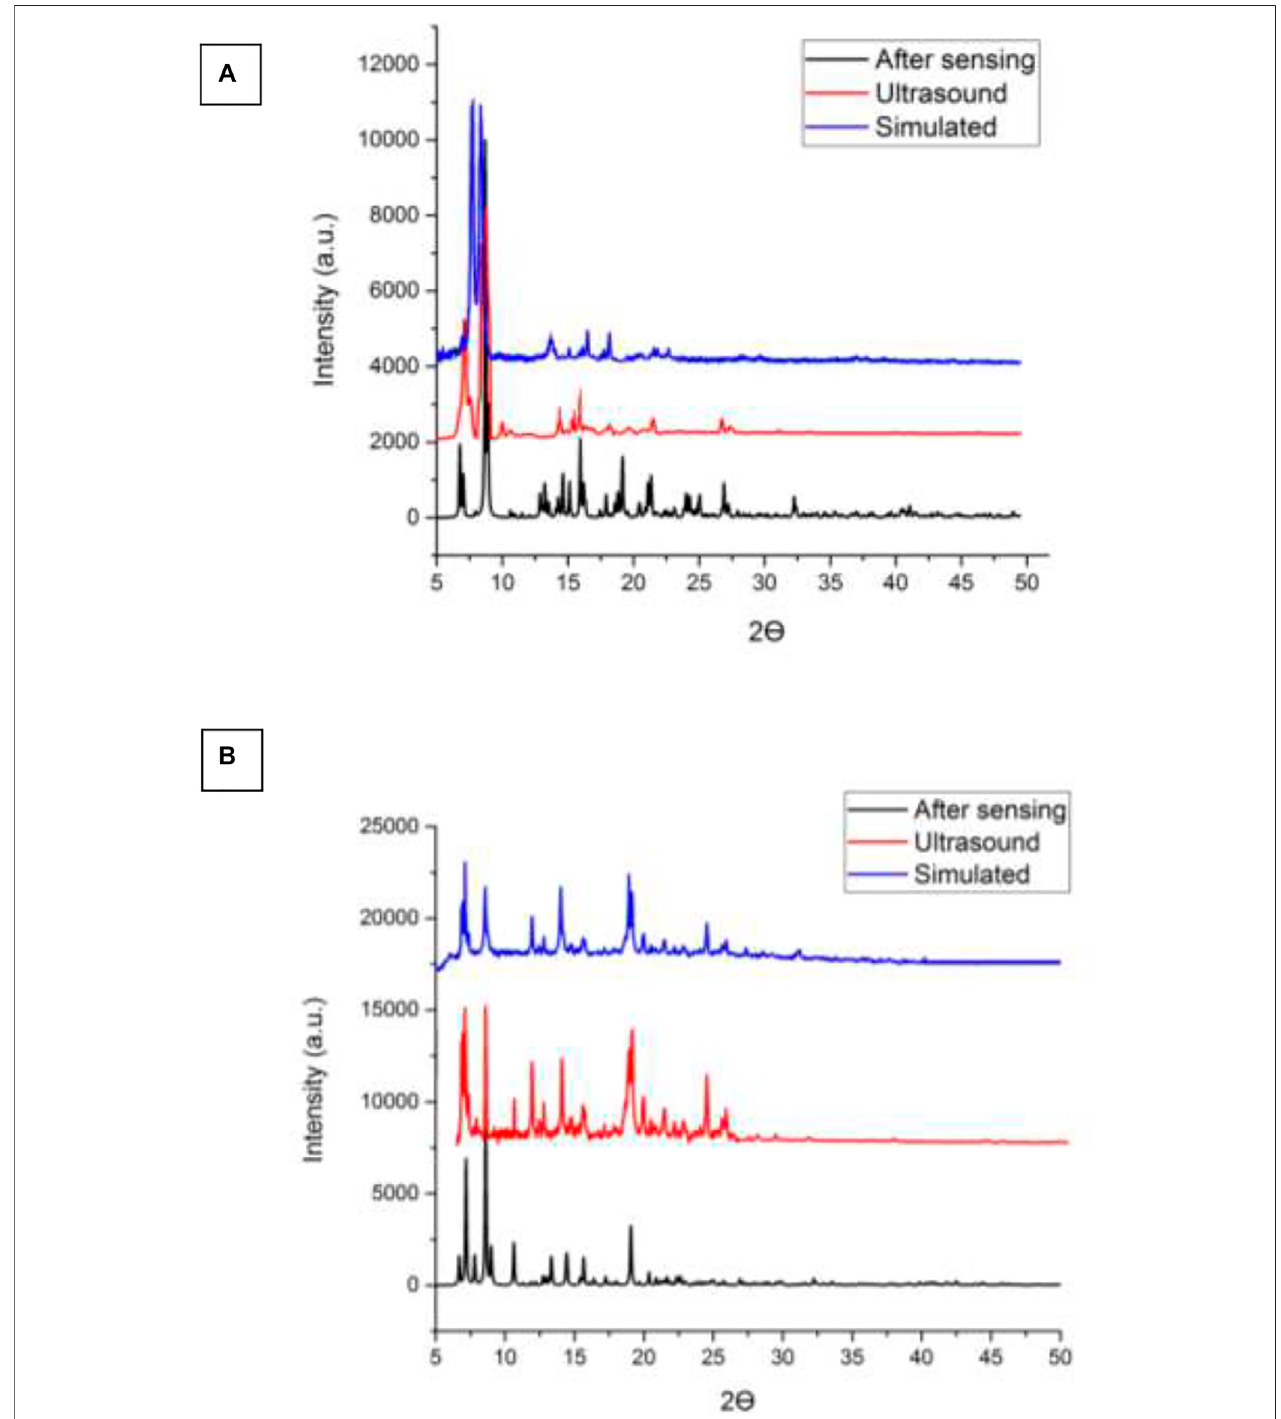
FIGURE 5 | (A) XRD patterns of the simulated pattern using by the single crystal data, as synthesized and nanostructure of compound (A) TMU-50 (B) TMU-51 prepared by the sonochemical process.